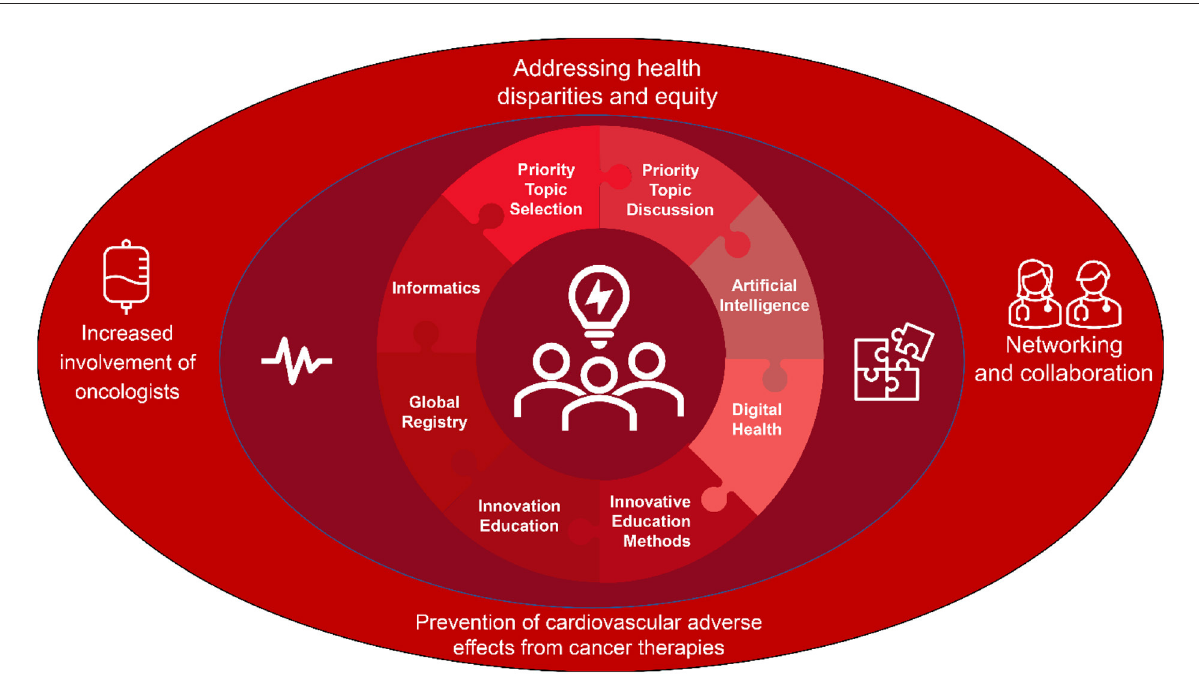
FIGURE1 ThinkTank priority topics selected and discussed. The Cardiology Oncology Innovation Network ThinkTank 2021 focused on priority topics preselected by network members and leaders at preceding gatherings, such as the virtual receptions at the end of daytime sessions of national or international cardiology, oncology, or cardio-oncology meetings. The priority topics selected and discussed were artificial intelligence and digital health, the role of informatics in the collaborative global cardio-oncology registry, and education on innovation coupled with innovative methods of education in cardio-oncology. These priority topics were considered in the setting of prevention of cardiovascular adverse effects from cancer therapies, addressing health disparities and equity, and increasing the presence and involvement of hematologists/oncologists in collaborations in